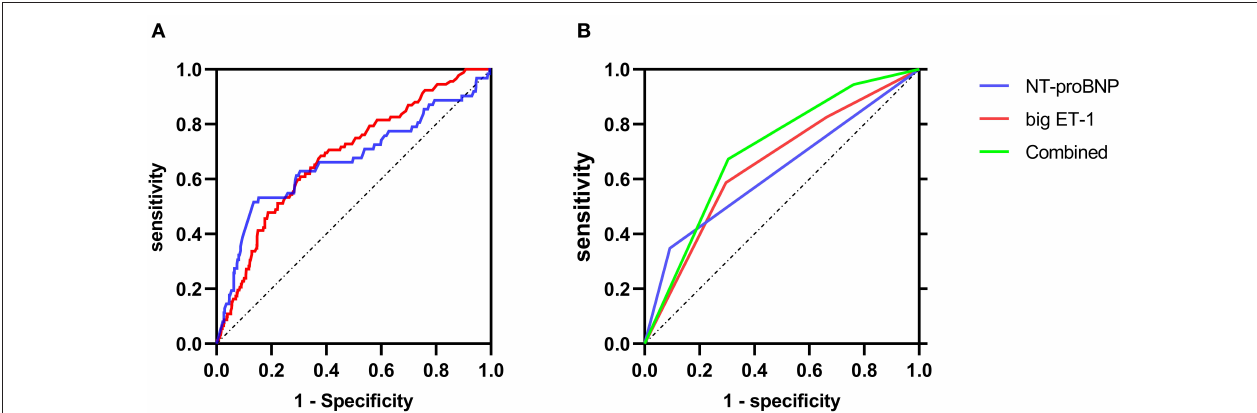
FIGURE 2 | ROC curves of primary endpoint predicted by NT-proBNP and big ET-1. (A) The ROC curves when big ET-1 and NT-proBNP were analyzed as continuous variables. (B) The ROC curves when big ET-1and NT-proBNP were analyzed as categorical variables, respectively, and the ROC curve for the combination of big ET-1 and